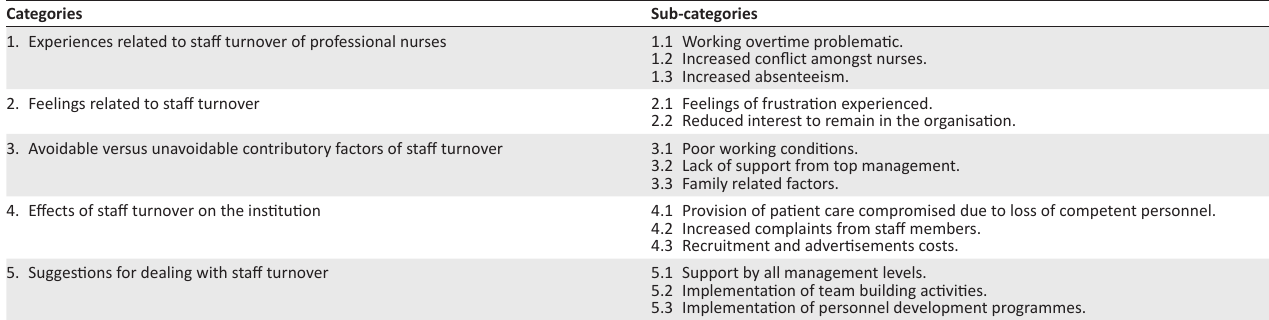
TABLE 1: Categories and sub-categories reflecting experiences of nursing unit managers at the MokopaneHospital.